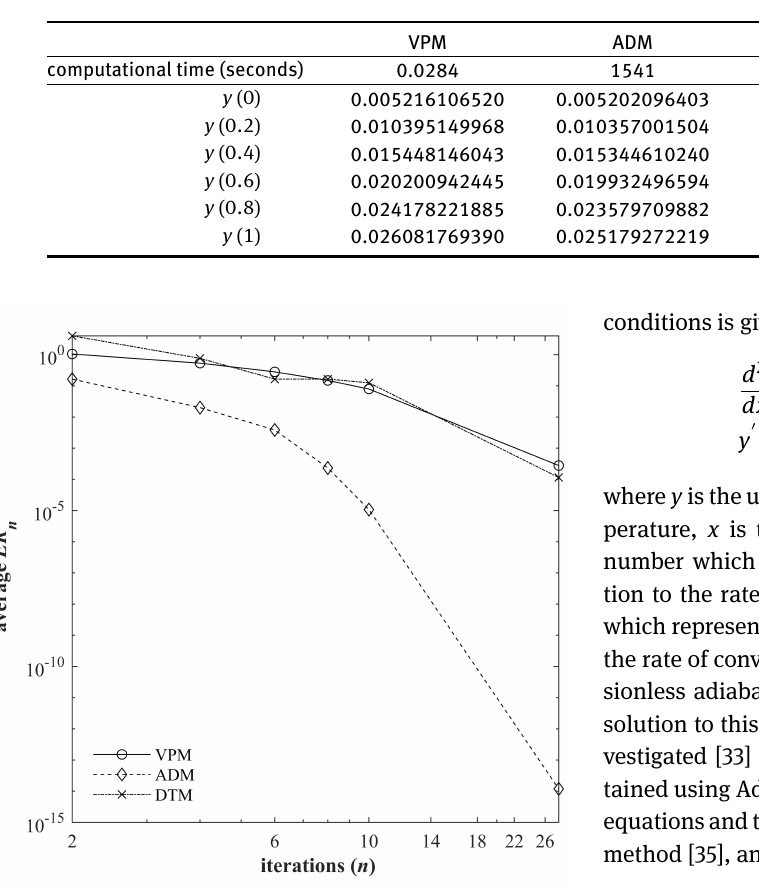
Table 3: Comparison of the required computational time to solve (33) and solutions at six data points